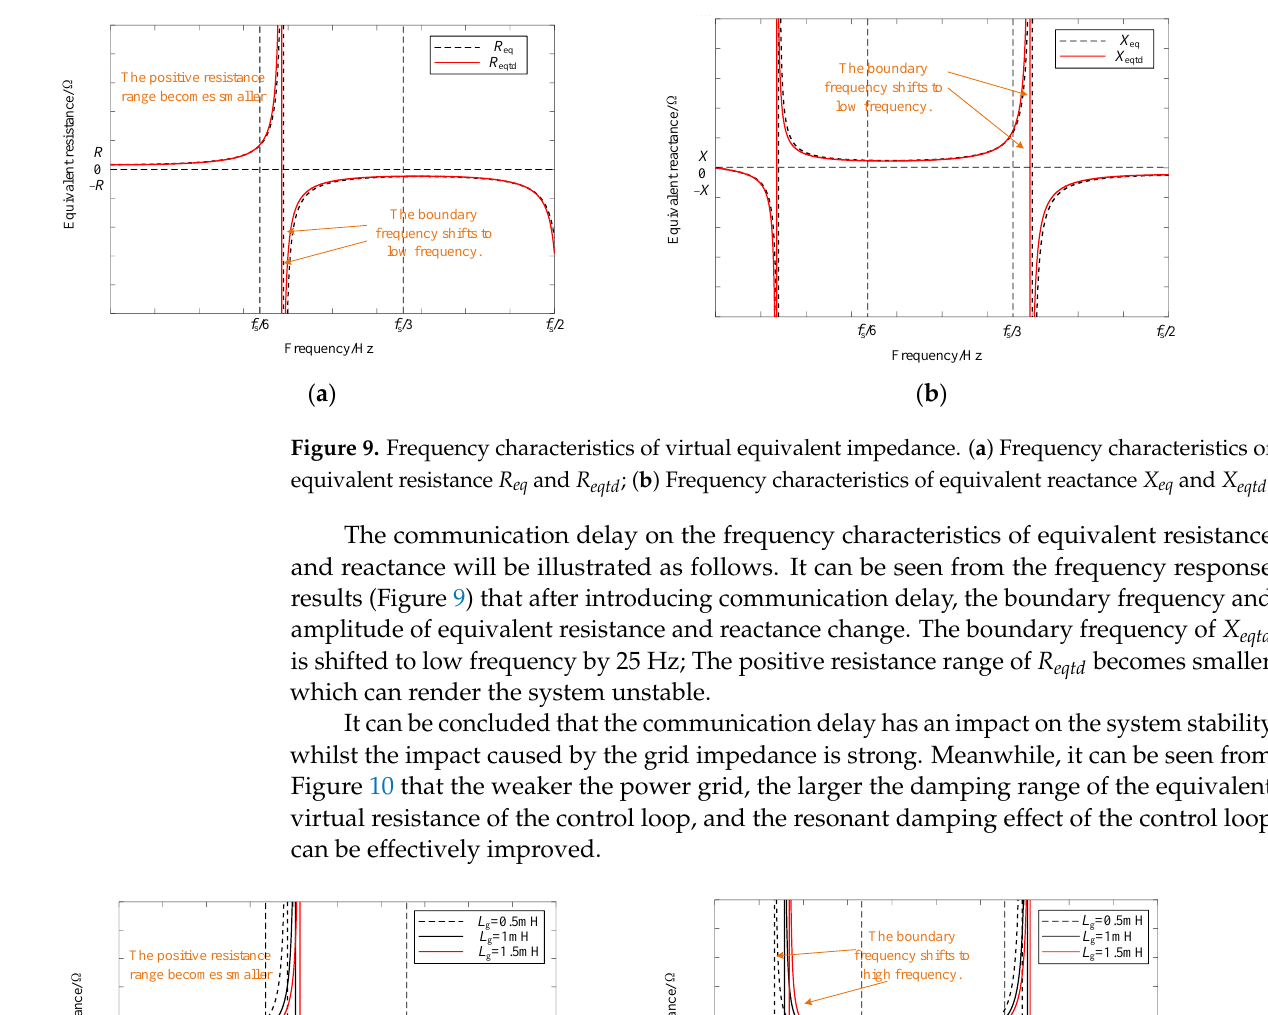
Table 4. Specifications of the Grid-tie Inverters.